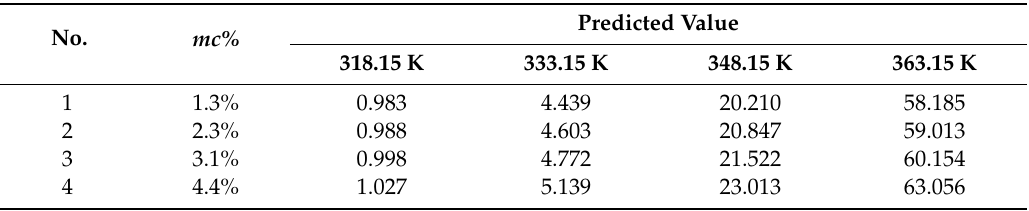
Table 4. The predicted shift factor of unaged pressboard with type I.